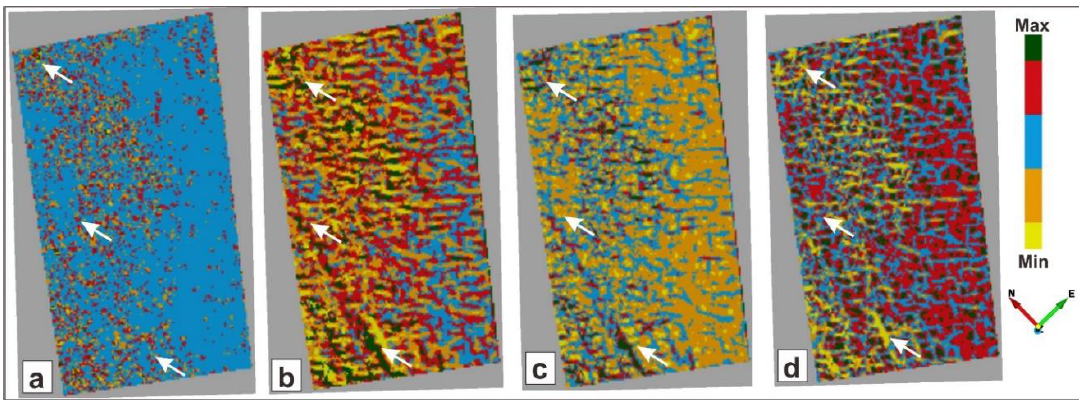
Figure 5. Time slices at 1780 ms of ( a ) minimum curvature, ( b ) maximum curvature, ( c ) most positive curvature, and ( d ) most negative curvature attributes. The white arrows show differences in discontinuities. The results of the maximum curvature highlighted the best results.